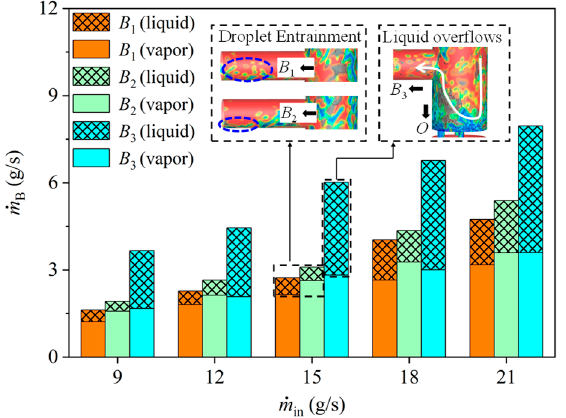
Figure 7. Mass flow rate in each branch outlet.